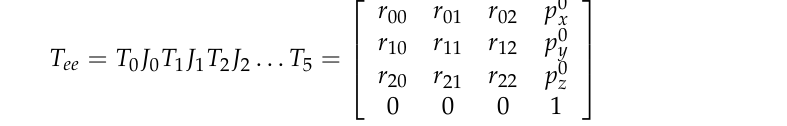
Figure 9. System architecture.